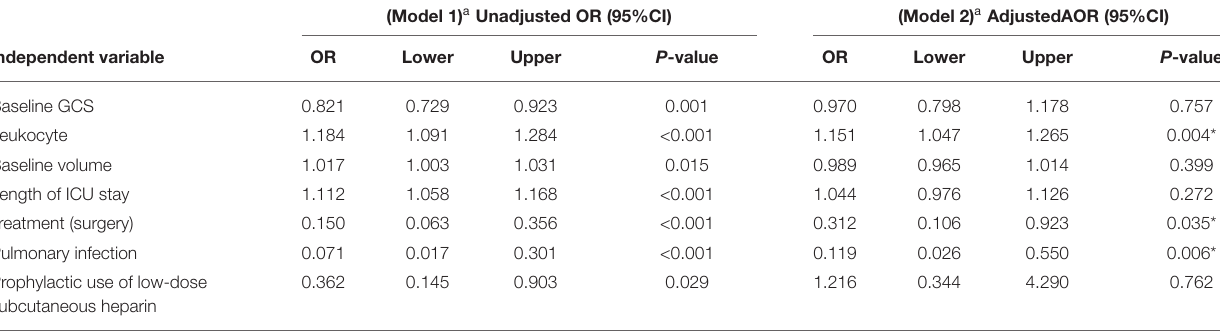
TABLE 2 | Predictors for LEDVT of spontaneous intracerebral hemorrhage in the multivariate model.